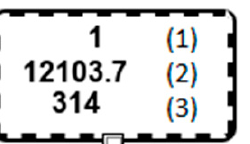
Figure 1. Description of node for kg of milk per lactation.